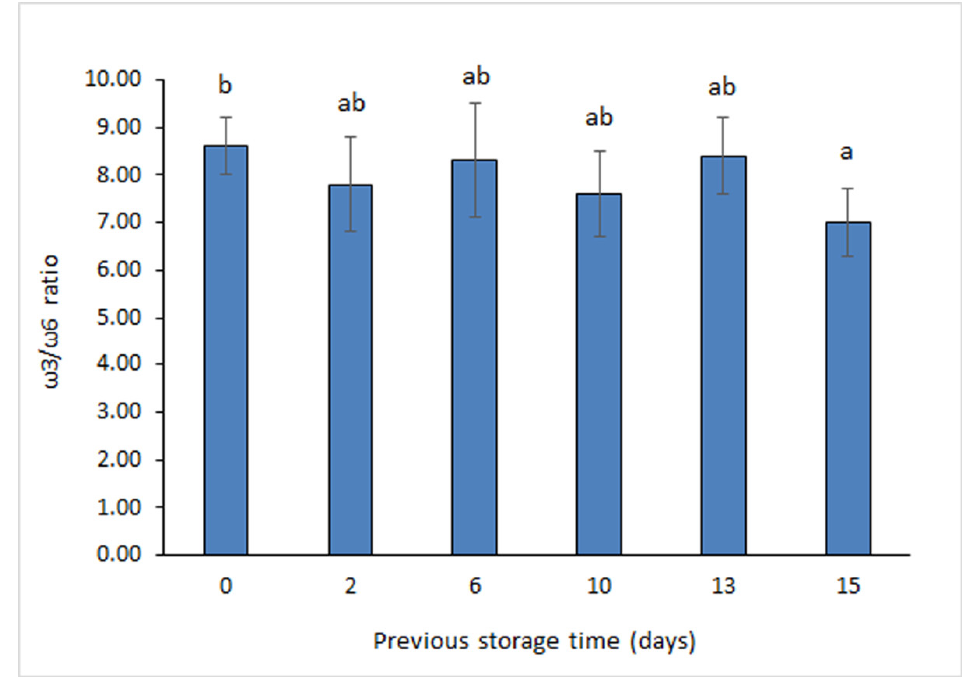
Figure 2. Determination of the ω3/ω6 ratio in canned sardines subjected previously to storage on ice. Average values of three replicates ( n = 3). Standard deviations are indicated by bars. Average values accompanied by different lowercase letters (a,b) denote significant differences ( p < 0.05).